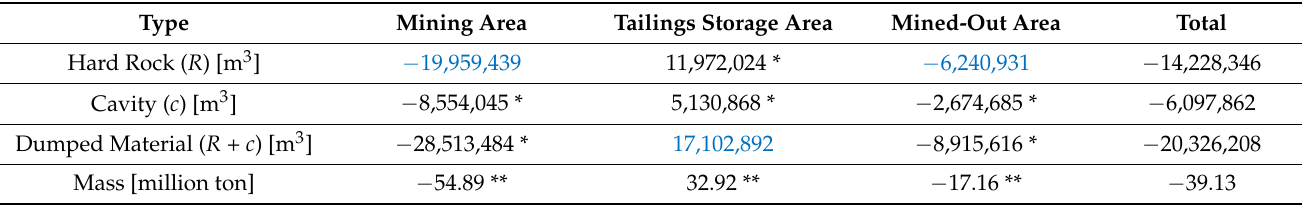
Table 3. Volume and mass changes between 2000 and